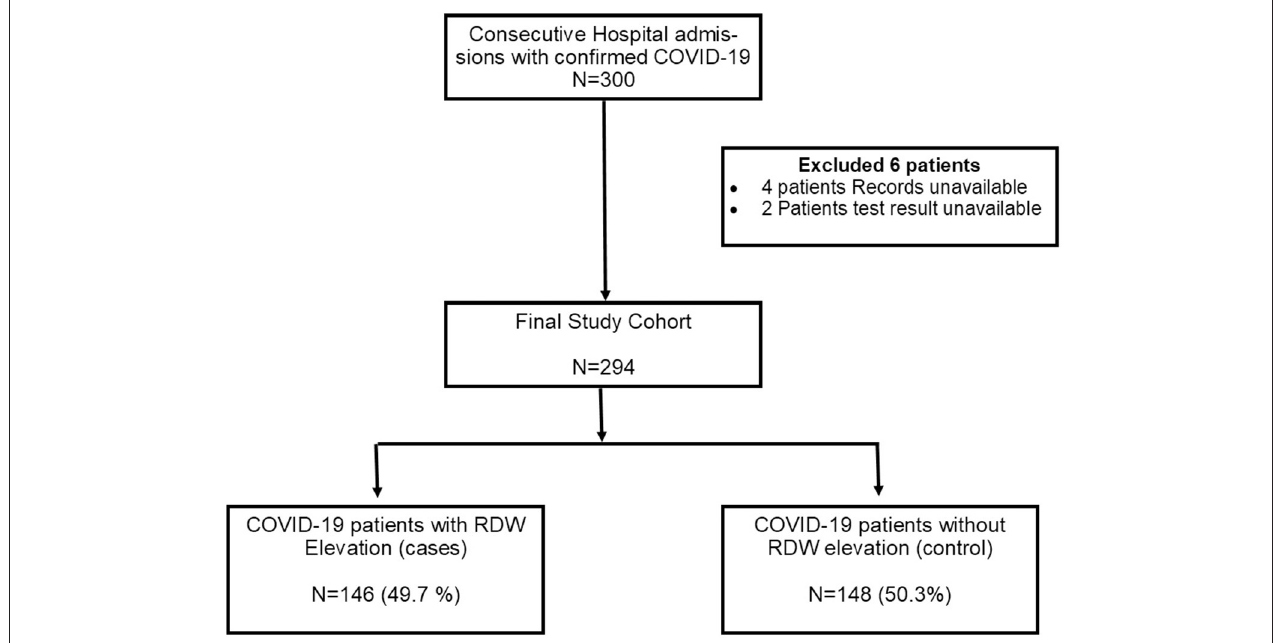
FIGURE 1 | Study flowchart. COVID-19, Coronavirus Disease 2019; RDW, Red blood cell distribution